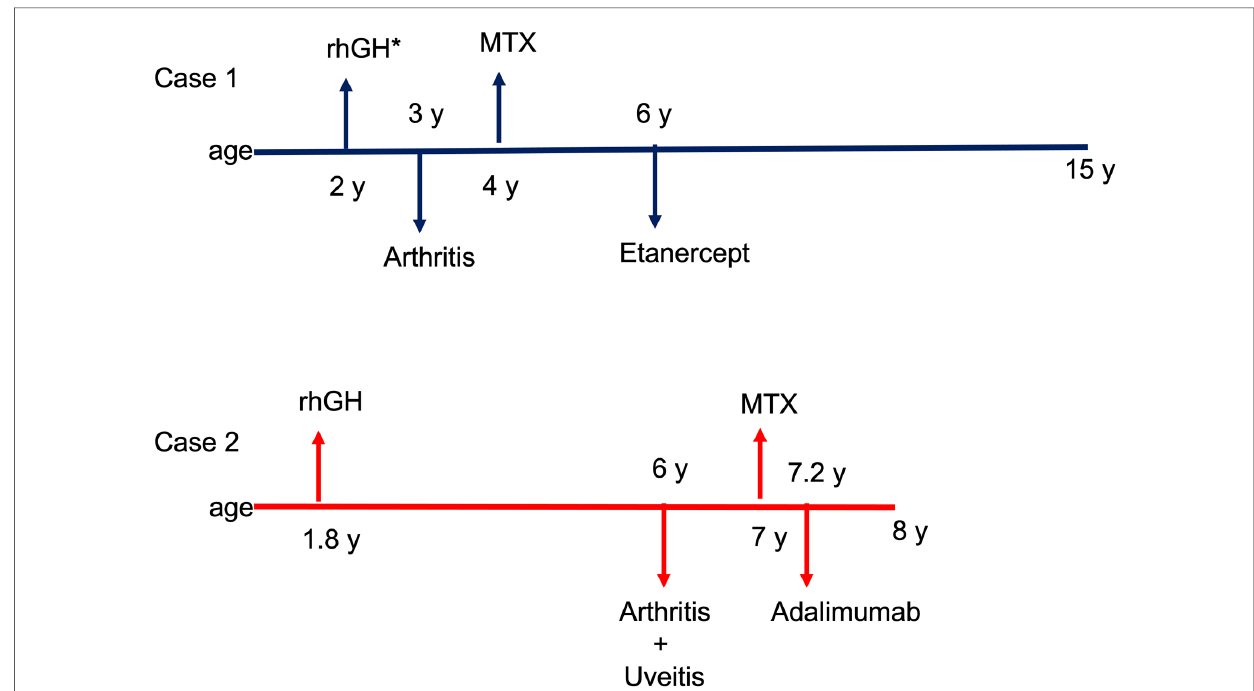
FIGURE 3 Timeline of clinical manifestations and treatments. RnGH, recombinant human growth hormone; MTX, methotrexate. *Treatment with rhGH was temporally discontinued for 15 months due to a diagnosis of